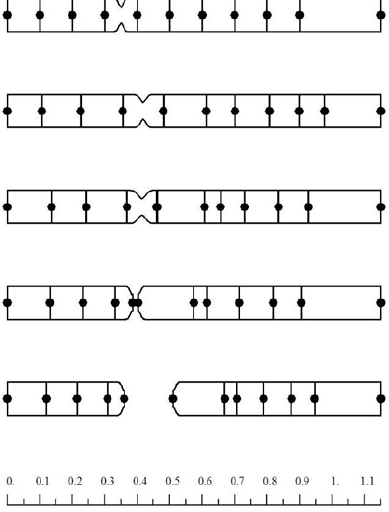
Figure 7: Five snapshots of the evolution of the domain from original domain to convergence.